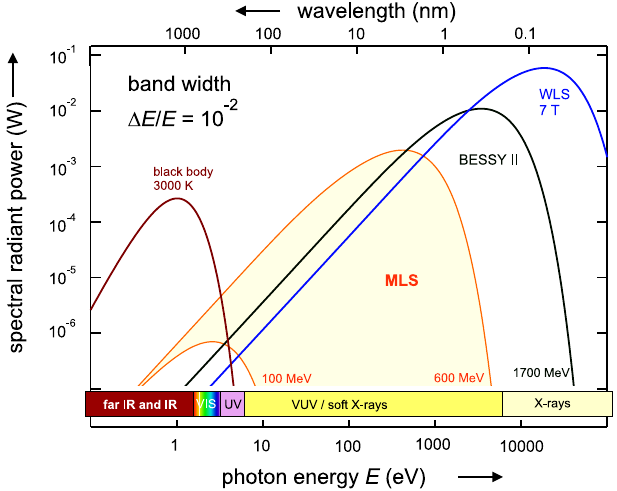
FIG. 1. (Color) Calculated spectral radiant power of various primary synchrotron radiation sources with different character- used by PTB as compared to a black- istic photon energies E c body radiator for typical angular acceptances. For the ¼ synchrotron radiation sources MLS and BESSY II ( E c 2 : 5 keV ), an electron beam current of 200 mA was assumed. ¼ The spectrum of a 7 T wavelength shifter (WLS, E c 13 : 5 keV ), operated at BESSY II and used by PTB for x-ray radiometry, is also